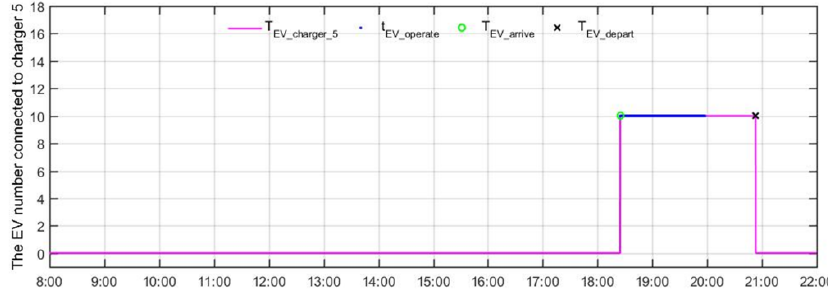
Figure 19. The operating time of EVs connected to charger 5 under ICDA.